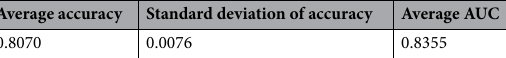
Table 1. Validation performance of CFPs-based model. In the first step of this study, we trained and validated the model only with color fundus photographs (CFPs).